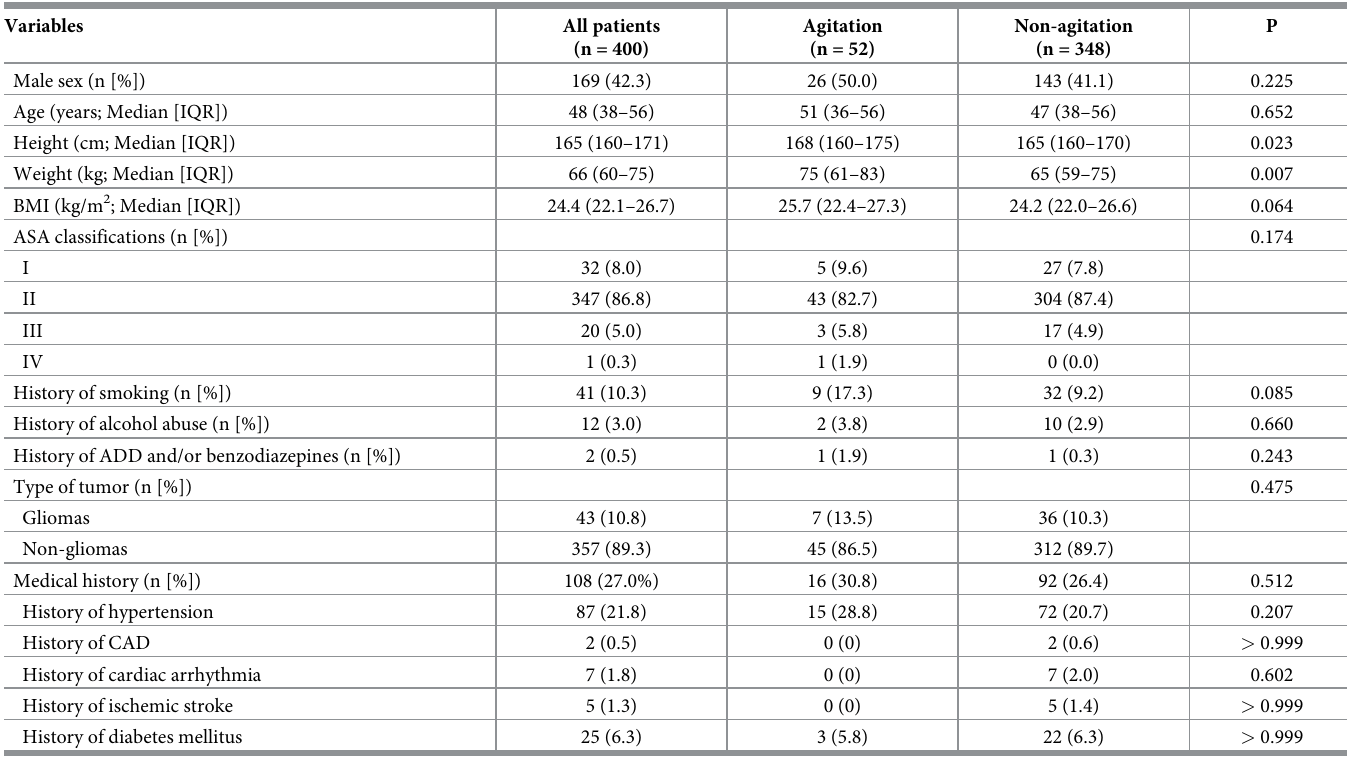
Table 1. Univariable analyses of baseline and preoperative